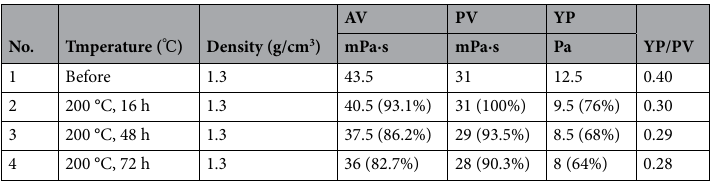
Table 2. Long term thermal stability of polymers